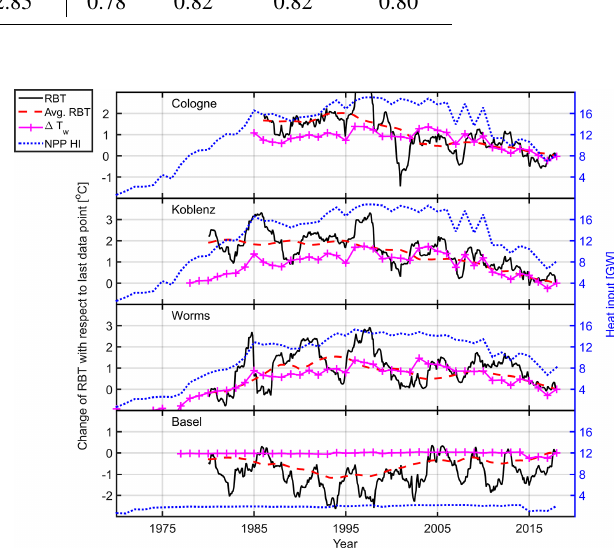
Figure 6. Rhine base temperature (RBT) from four monitoring sta- tions (black solid line). The red dashed line is the RBT 4-year running mean. The magenta line with the “ + ” markers shows the (cid:49) RBT relative to the last year. The blue dotted line is the upstream heat input (HI) by NPPs; see Sect.